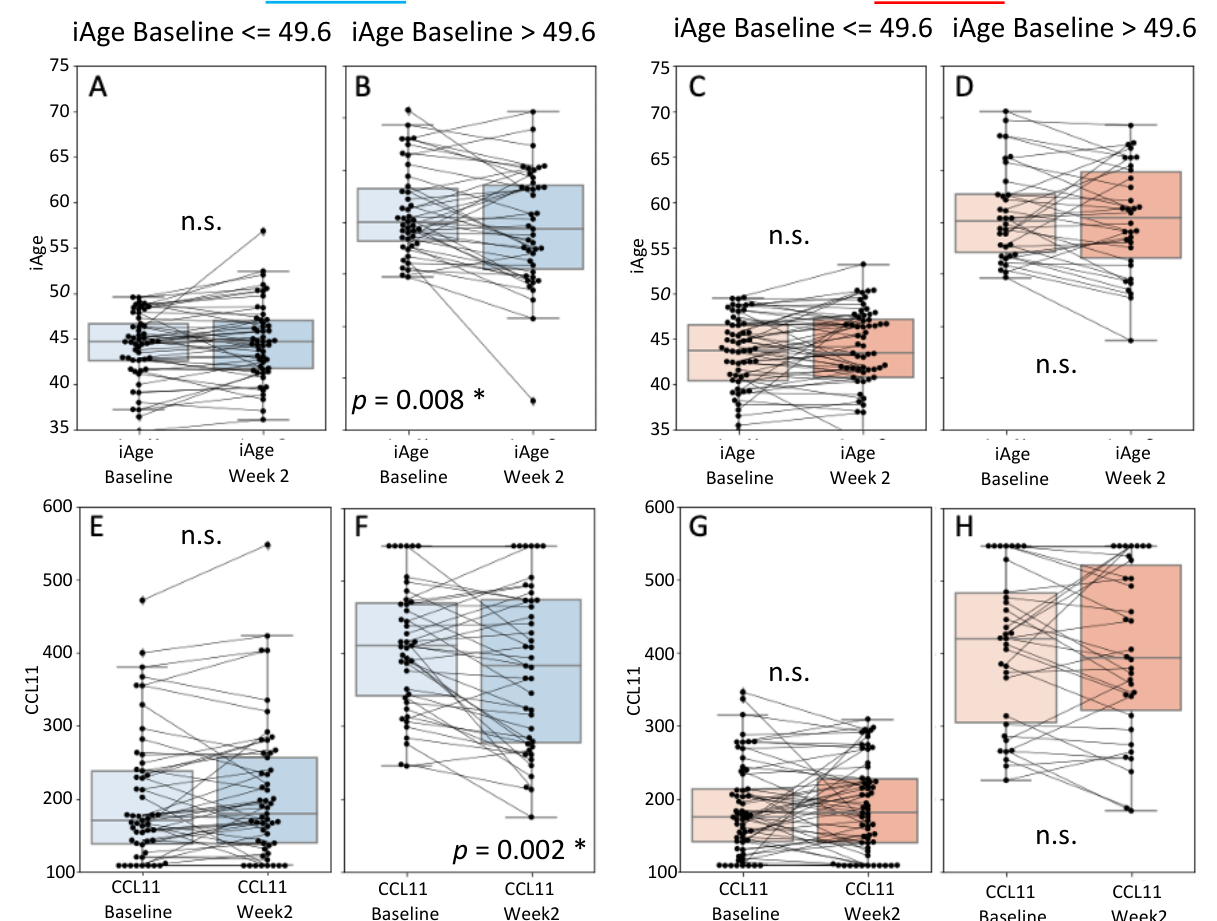
Figure 2. Effects of stratification by baseline iAge ® on changes in iAge ® and CCL11 after 2 weeks of Oats treatment. The value for iAge ® or CCL11 (y-axes) is provided for each patient as a black dot, and the change in that value for each patient between baseline as week 2 (x-axes) is represented by a connecting black line. The statistics for each group are shown using box plots, and significance between baseline and week 2 was calculated using a pairwise two-tailed t -test. The optimal cut-point for baseline iAge ® was calculated to be 49.6 years using cutpointR. Stratification of individuals treated with oats by baseline iAge ® showed no significant (n.s.) change in iAge ® at week 2 for those with a low baseline iAge ® ( A ), with a significant (asterisk) decrease for those with a high baseline iAge ® ( B ). No change was observed in iAge ® at week 2 with the placebo group ( C , D ). Stratification of individuals treated with oats by baseline iAge ® showed no significant change in CCL11 at week 2 for those with a low baseline iAge ® ( E ) and a significant decrease for those with a high baseline iAge ® ( F ). No change was observed in iAge ® at week 2 with the placebo group ( G , H ). CCL11, Eotaxin; SoluOBC, oat product providing 3 g of β -Glucan.